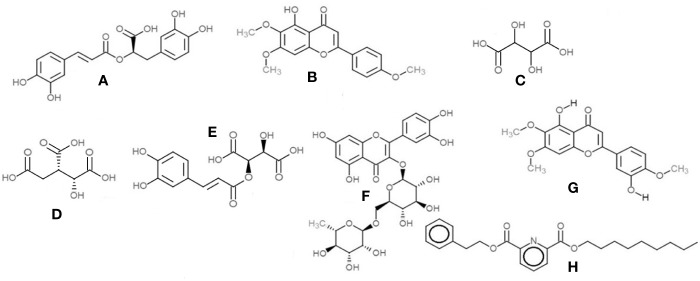
Chemical structures of the main compounds identified from crude herbal extracts of O.basilicum: (A) Rosmarinic acid; (B) Salvigenin; (C) Tartaric acid; (D) Isocitric acid; (E) Caftaric acid; (F) Rutin; (G) Eupatorin; and (H) 2,6-Pyridinedicarboxylic acid, nonyl phenethyl ester.